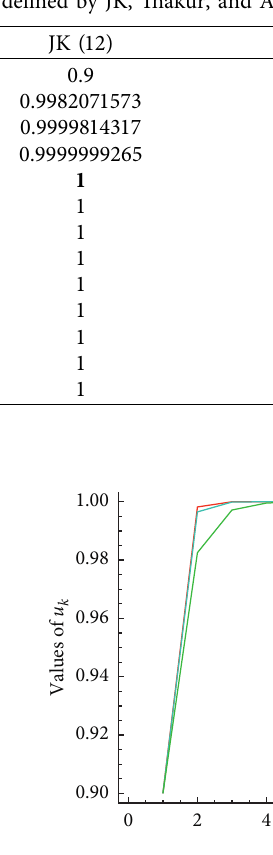
Figure 1: Convergence behavior of JK (12), Thakur (8), and Agarwal (6) iterates to converge to q � 1, a unique fixed point of the self-map F � 0 . in Example 1 where u 1